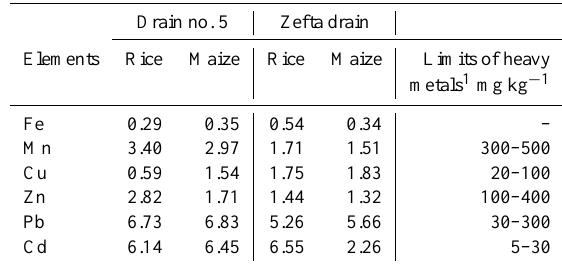
Table 2. Bioconcentration factors of heavy metals in maize and rice shoots grown in soils irrigated by waste water from Zefta drain, drain no. 5, and limits of heavy